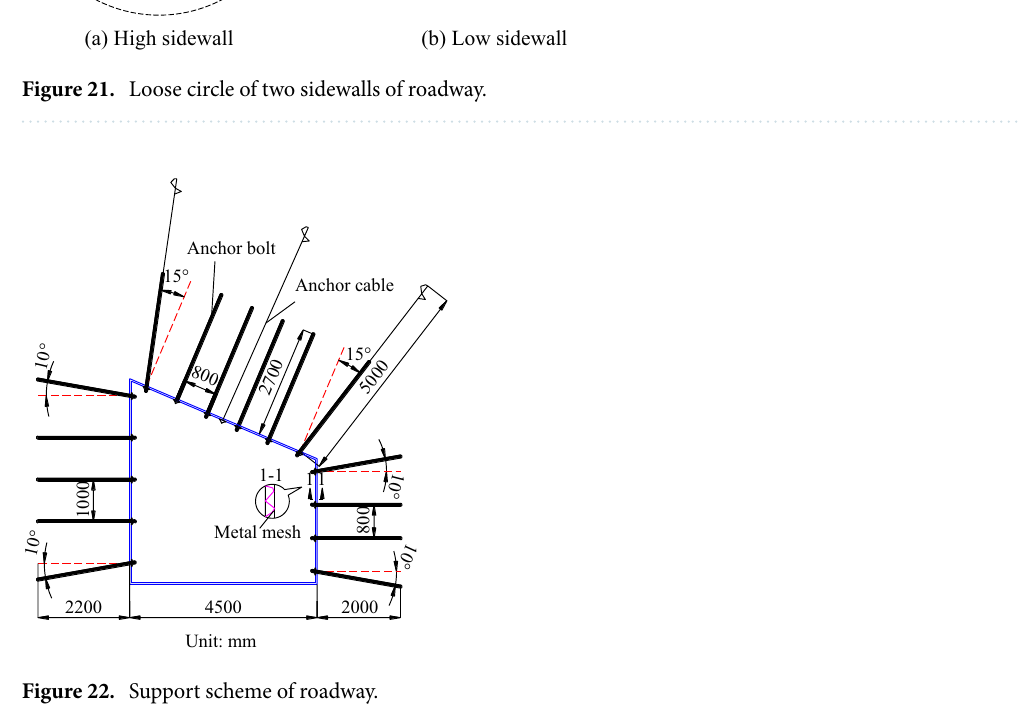
Figure 22. Support scheme of